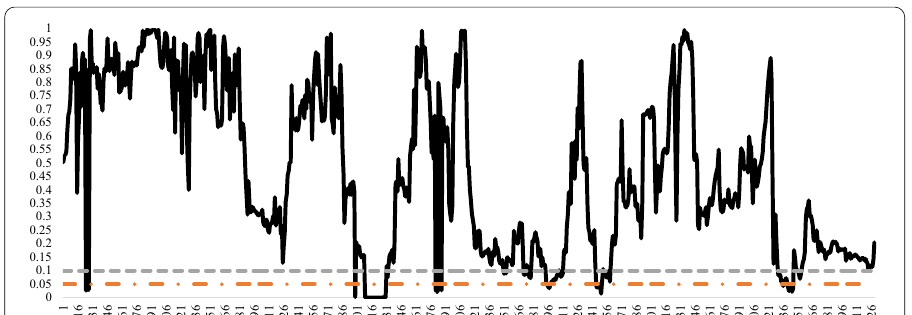
Fig. 18 The evolving p values of the AQ test statistic checked for the WTI in 100-day window length